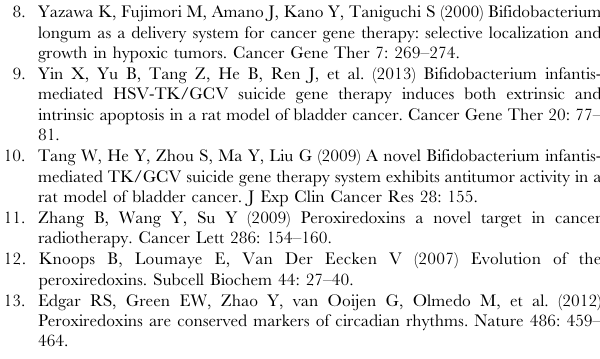
Table S1 iTRAQ Analysis of Differentially Expressed Proteins in normal saline group (iTRAQ 114), BI-TK group (iTRAQ 115), BI/PGEX-1 group (iTRAQ 116) and BI group (iTRAQ